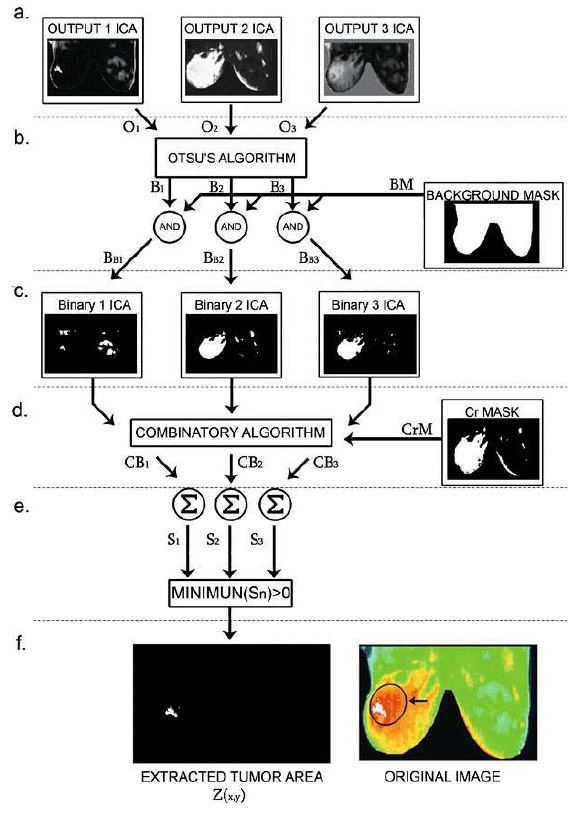
Figure 6. The process of extraction of the tumor area [28].